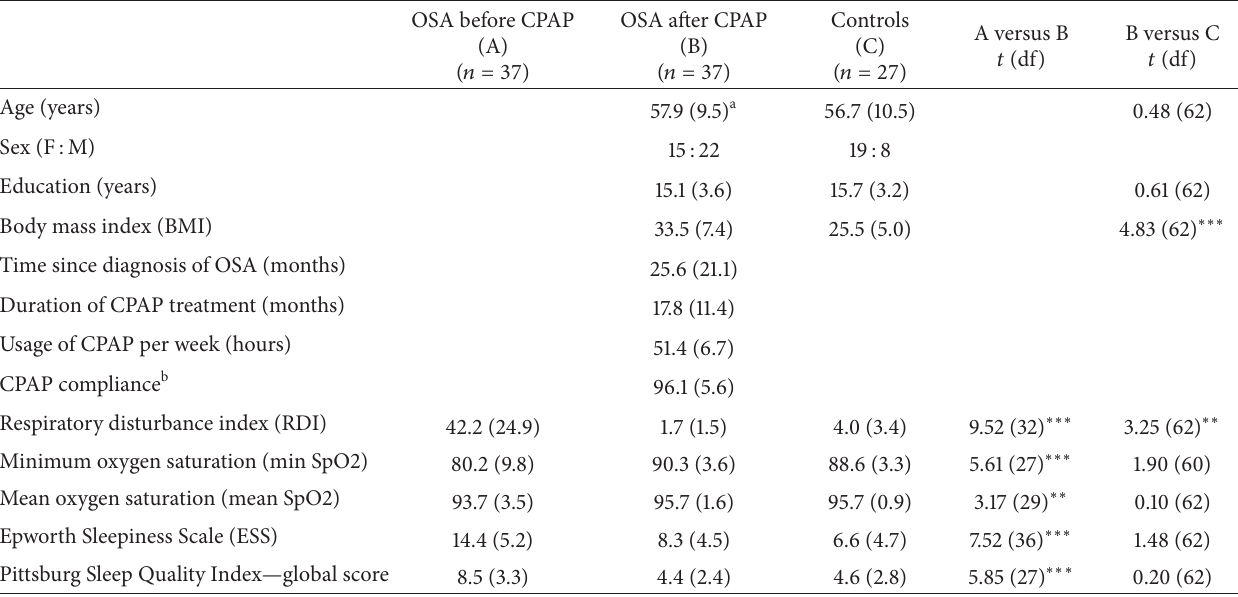
Table 1: Participants’ characteristics and OSA group CPAP treatment information.